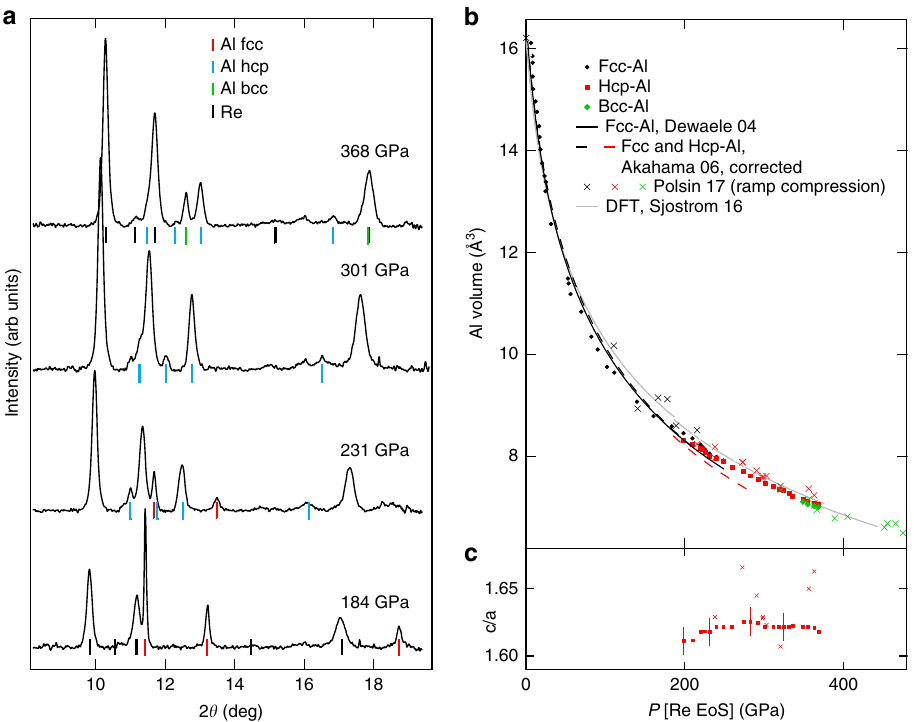
Fig. 5 Aluminum phases and equation of state data. a XRD spectra collected at the center of the pressure chamber for run 4 (aluminum sample in a rhenium gasket). The exposure time was 40 s. The ticks indicate the XRD peaks from the gasket (black) and from the sample (red, blue, and green). Ticks for Re are not plotted for the spectra collected at 231 and 301 GPa. b Volume of aluminum measured in run 4. The pressure is estimated using rhenium gasket equation of state 33 . The black line is the quasi-hydrostatic equation of state of fcc aluminum, measured up to 165 GPa 38 . The dashed lines are the equations of state of the fcc and hcp phases measured under non-hydrostatic compression in a standard diamond anvil cell 27 , after correction of the pressure metrology (see text). The crosses are volume vs. stress points measured in recent ramp-compression experiments 26 , and the gray line the ab initio predicted 0 K equation of state 47 . c c / a ratio in hcp-Al measured here and by ramp compression